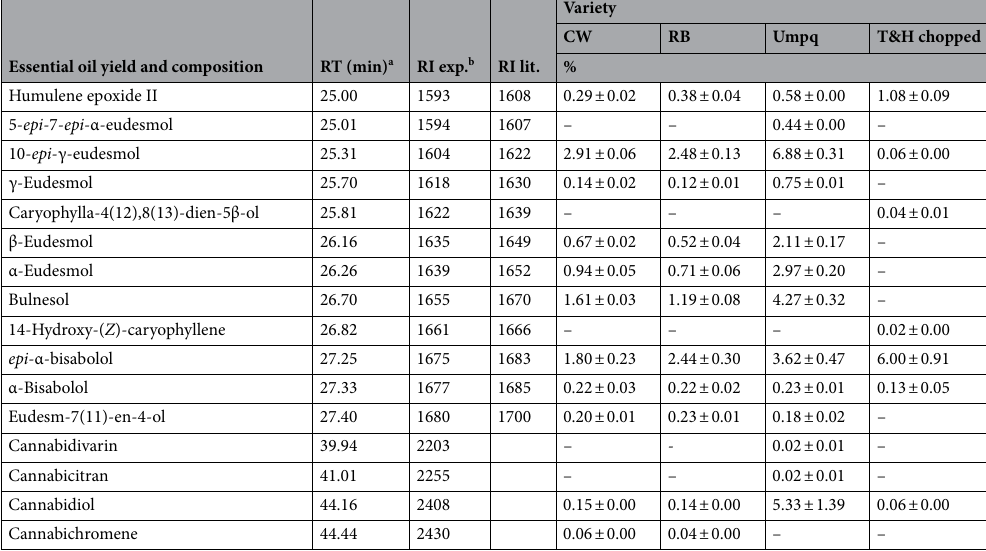
Essential oil yield and composition